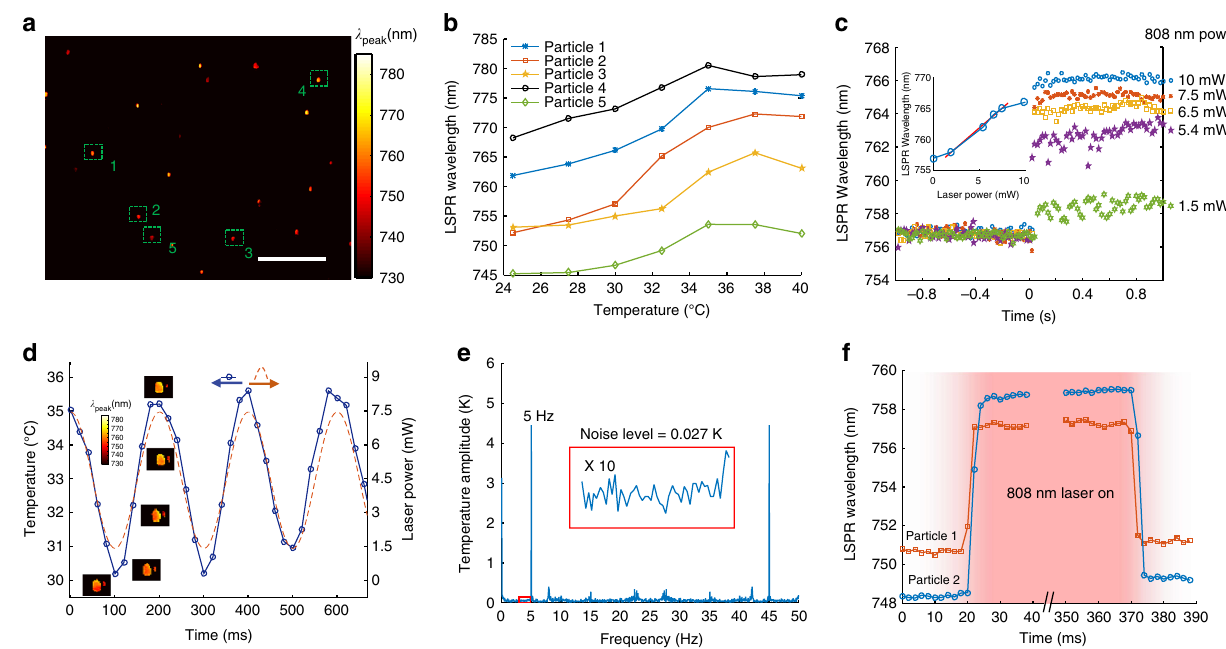
Fig. 4 Spatiotemporal thermometry by the spatiotemporal resolution plasmonic spectroscopy (SRPS). a LSPR spectral mapping of AuNRs@pNIPAAm at 25 °C. Scale bar is 10 μ m. b Temperature-dependent scattering spectral peak wavelengths of selected AuNRs@pNIPAAm particles marked by squares in a . c LSPR wavelength of an AuNR@pNIPAAm particle numbered by 2 in a response to the 808-nm laser with power of 1.5 (hexagrams), 5.4 (pentagrams), 6.5 (squares), 7.5 (asterisks), and 10 mW (circles) at t = 0 s. In the inset, LSPR wavelength is plotted to the 808-nm laser power (circles) while a solid line is fi tted using data points from 5.4 to 7.5 mW. d Time-dependent applied 808 nm laser power (dash line) and the obtained temperature of the same particle in c (circles). Insets, LSPR wavelength images of the heated AuNR@pNIPAAm particle producing the temperature data. e Fourier spectrum of the temperature data in d . Inset is 10 times magni fi cation of the region marked by the solid square. f Time-dependent LSPR wavelengths of two AuNR@pNIPAAm particles response to the 808-nm laser on and off. Sample interval is 2